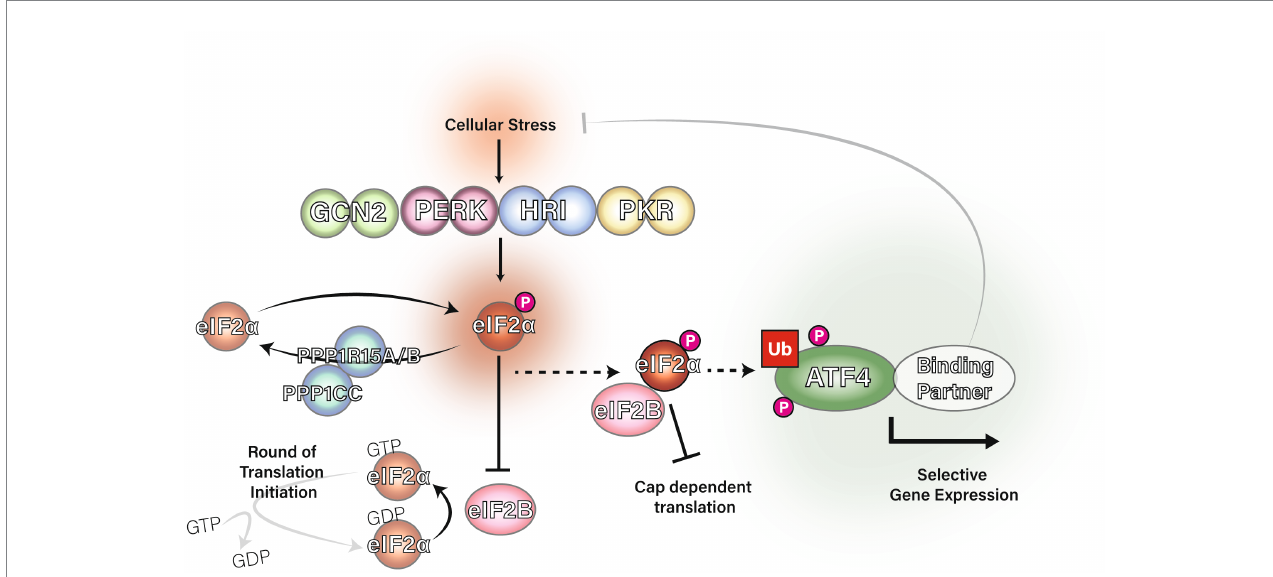
FIGURE 1 The integrated stress response and regulation of eIF2 α . The eIF2 kinases GCN2, PERK, PKR and HRI phosphorylate eIF2 α at serine 51 in response to a range of stress stimuli. DNAJC3 (also known as P58IPK) is known to inhibit the activity of GCN2, PERK and PKR (Roobol et al., 2015). Protein phosphatase 1 regulatory subunit 15A (PPP1R15A) and PPP1R15B are eIF2 adapters for the phosphatase catalytic subunit, PPP1CC, which downregulate the ISR via dephosphorylation of eIF2 α at serine 51. PPP1R15B is constitutively expressed whereas PPP1R15A is induced by the integrated stress response in a negative feedback mechanism (Novoa et al., 2001; Brush et al., 2003; Jousse et al., 2003; Kojima et al., 2003). Phosphorylation of eIF2 α causes eIF2 to inhibit eIF2B from acting as a guanine nucleotide exchange factor for eIF2 and the initiator Met-tRNAi cannot bind eIF2 unless GTP is present. Ultimately, eIF2 α phosphorylation inhibits eIF2 ternary complex formation and therefore inhibits translation initiation leading to upregulation of